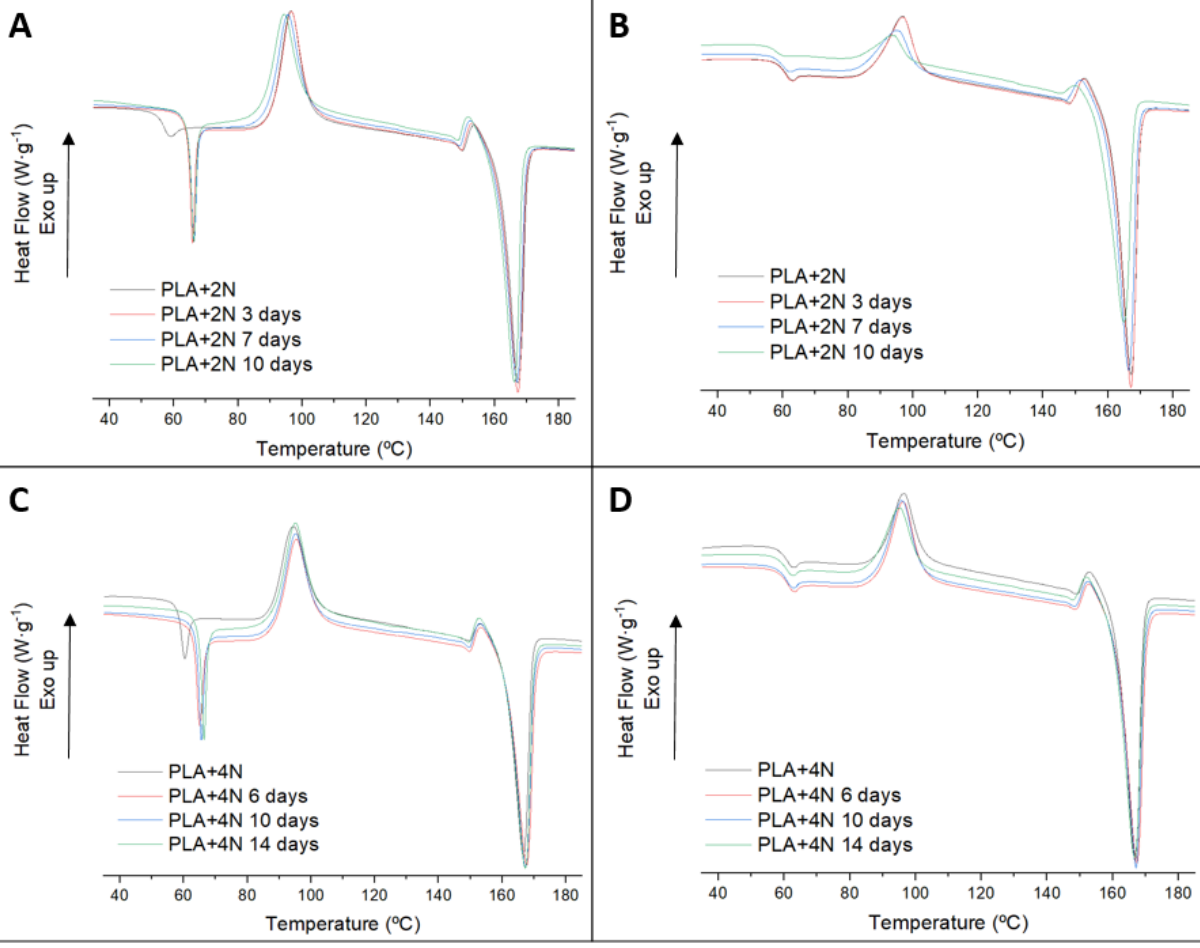
Figure 8. First, (left column) and second (right column) of nanocomposites: 2% ( A , B ) and 4% ( C , D ) of nanoclay content.